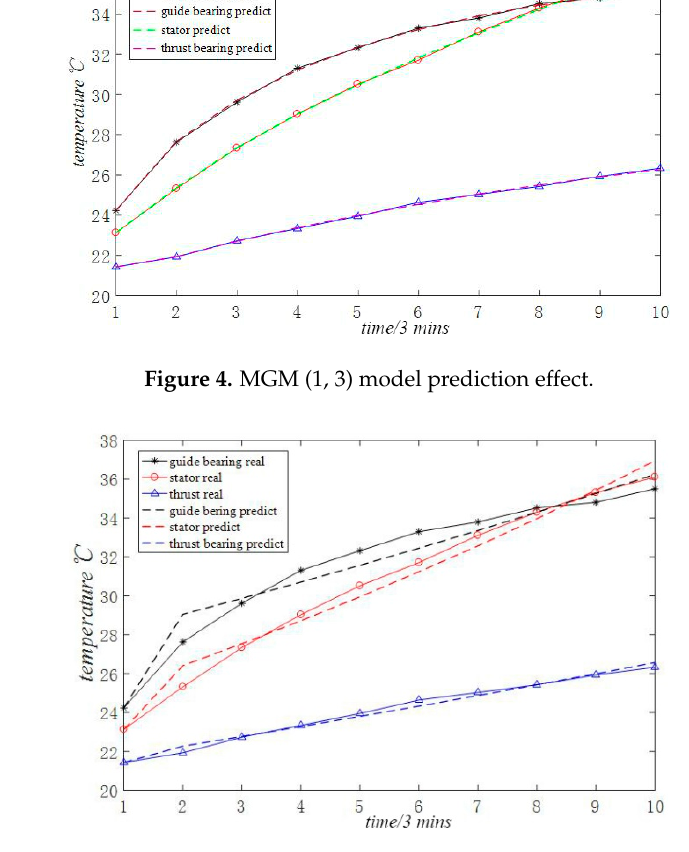
Figure 5. GM (1, 1) model prediction effect.